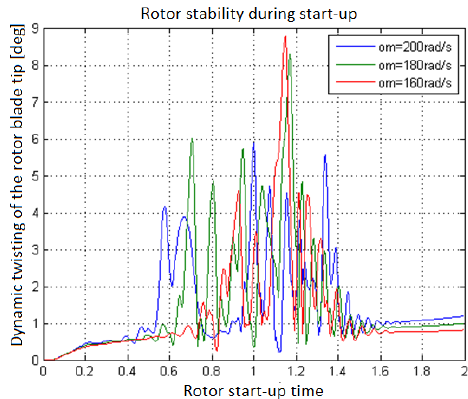
Fig. 21. Dynamic twist angle for the case of a rotor stability